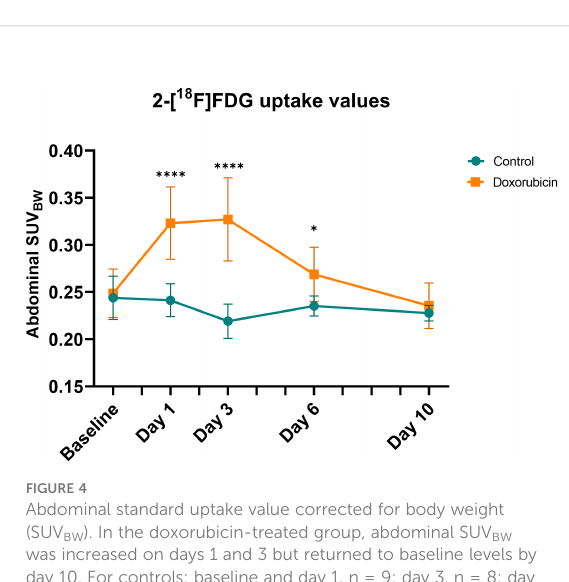
FIGURE 4 Abdominal standard uptake value corrected for body weight (SUV BW ). In the doxorubicin-treated group, abdominal SUV BW was increased on days 1 and 3 but returned to baseline levels by day 10. For controls: baseline and day 1, n = 9; day 3, n = 8; day 6, n = 6; and day 10, n = 4. For doxorubicin: baseline, n = 13; day 1 and 3, n = 12; day 6 and day 10, n = 10. Data are presented as means ± sd. *p ≤ 0.05, ****p ≤